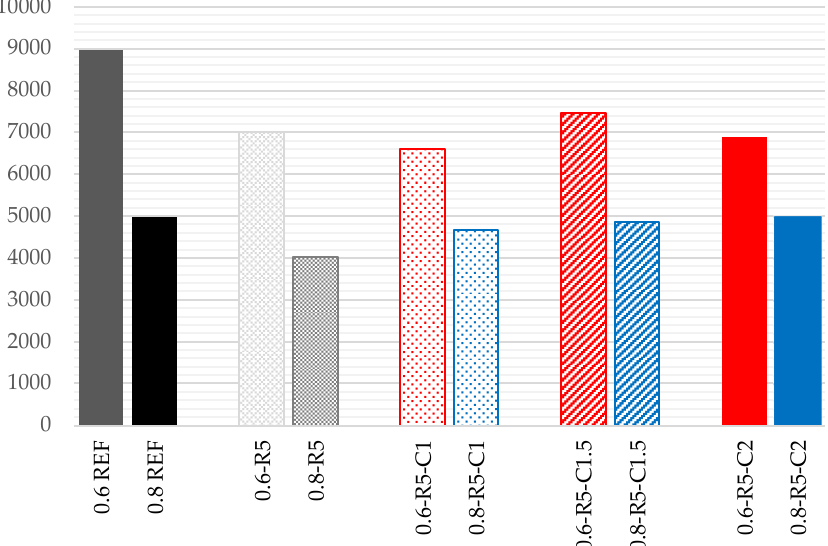
Figure 6. Young’s modulus (MPa).